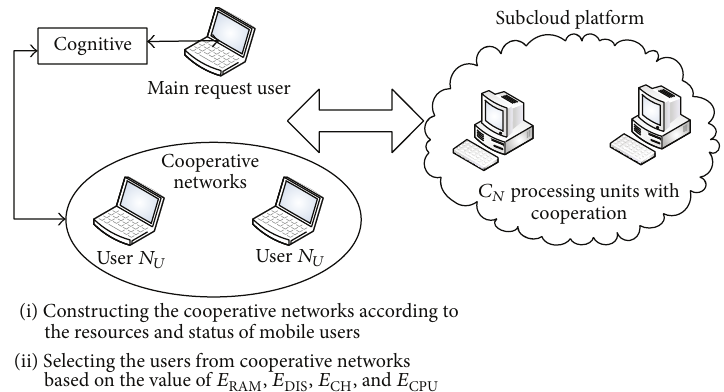
Figure 2: Cooperative cognitive cloud